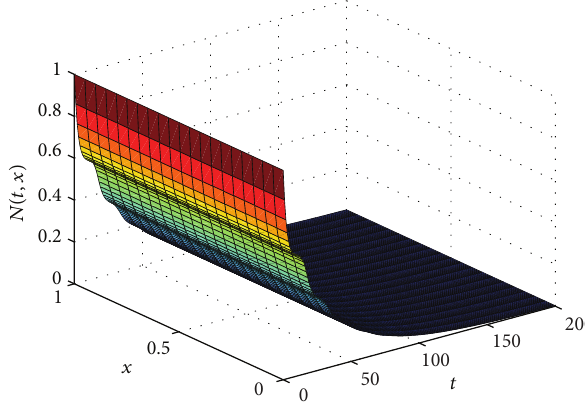
= 15 , and 𝑁 ∗ = 4.58145 . Initial condition is 𝜓(𝜃,𝑥) = 4 + sin 𝜃 , 𝜏 2 (𝜃, 𝑥) ∈ [−15,0] × [0,1] .